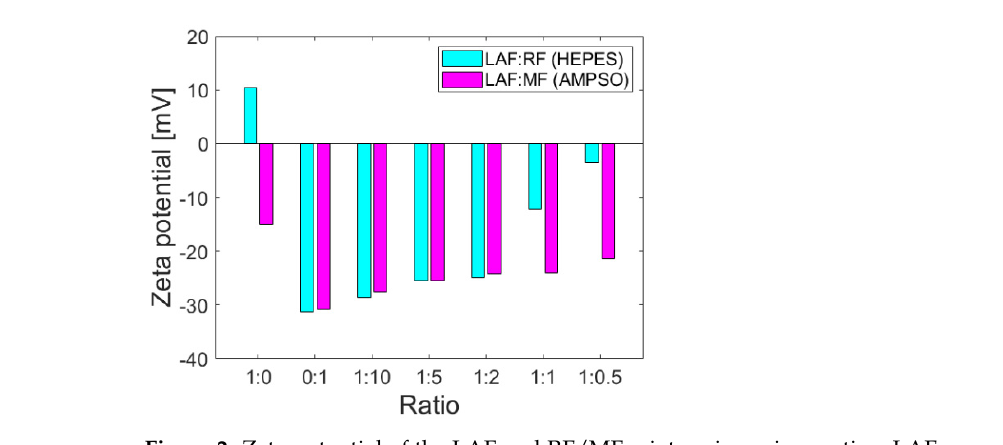
Figure 2. Zeta potential of the LAF and RF/MF mixture in various ratios. LAF concentration was fixed at 2 mg/mL.